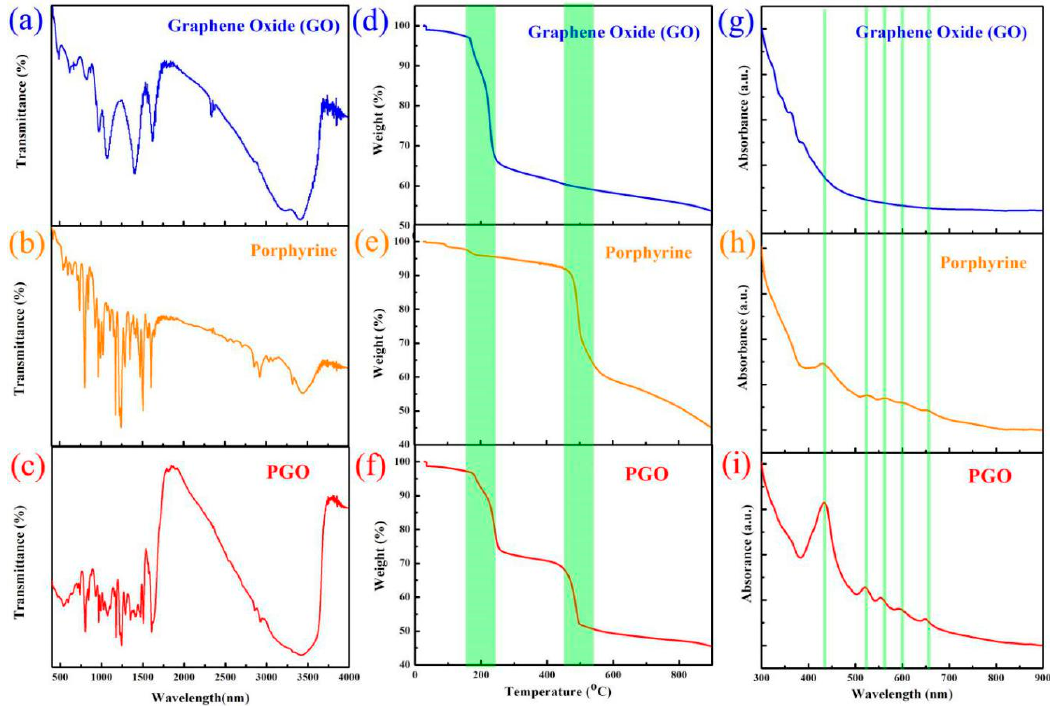
Figure 2. ( a – c ): FTIR spectra of GO, porphyrin, and PGO; ( d – f ): TGA curves of GO, porphyrin, and PGO; ( g – i ): UV-vis absorption spectra of GO, porphyrin and PGO.